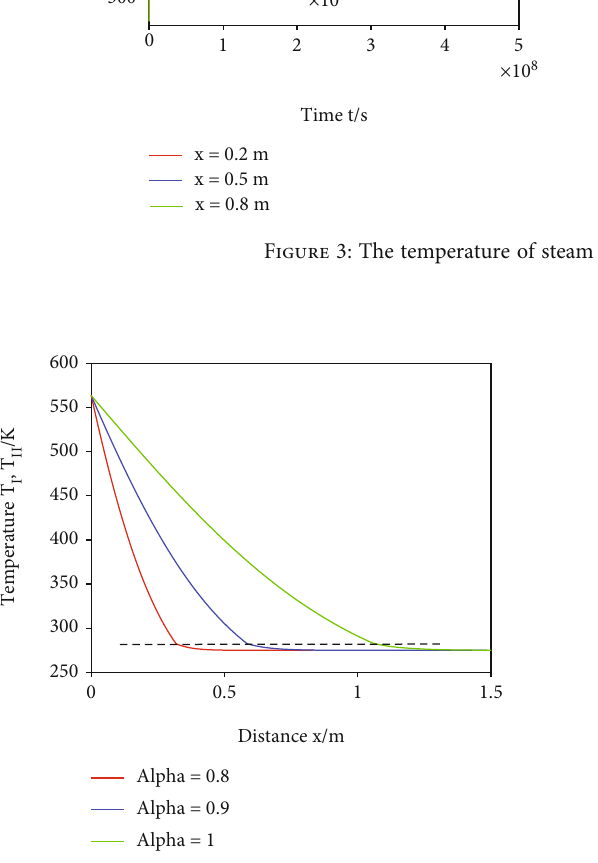
Figure 4: The temperature distribution at di ff erent distances. Figure 5: The temperature distribution at di ff erent times.